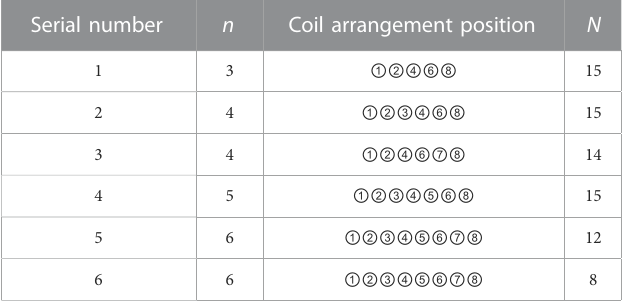
TABLE 3 Optimal parameter con fi gurations under different numbers of relay coils.